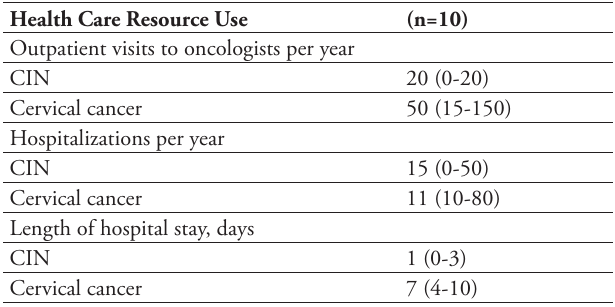
Abbreviation: CIN, cervical intraepithelial neoplasia. a Values are presented as median (interquartile